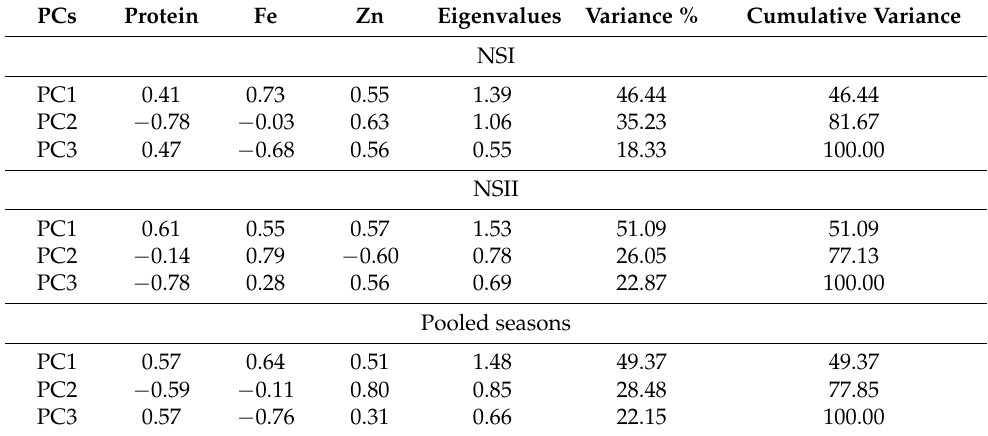
Table 1. PCA estimation, eigenvalue, and their percent variance contribution for grain